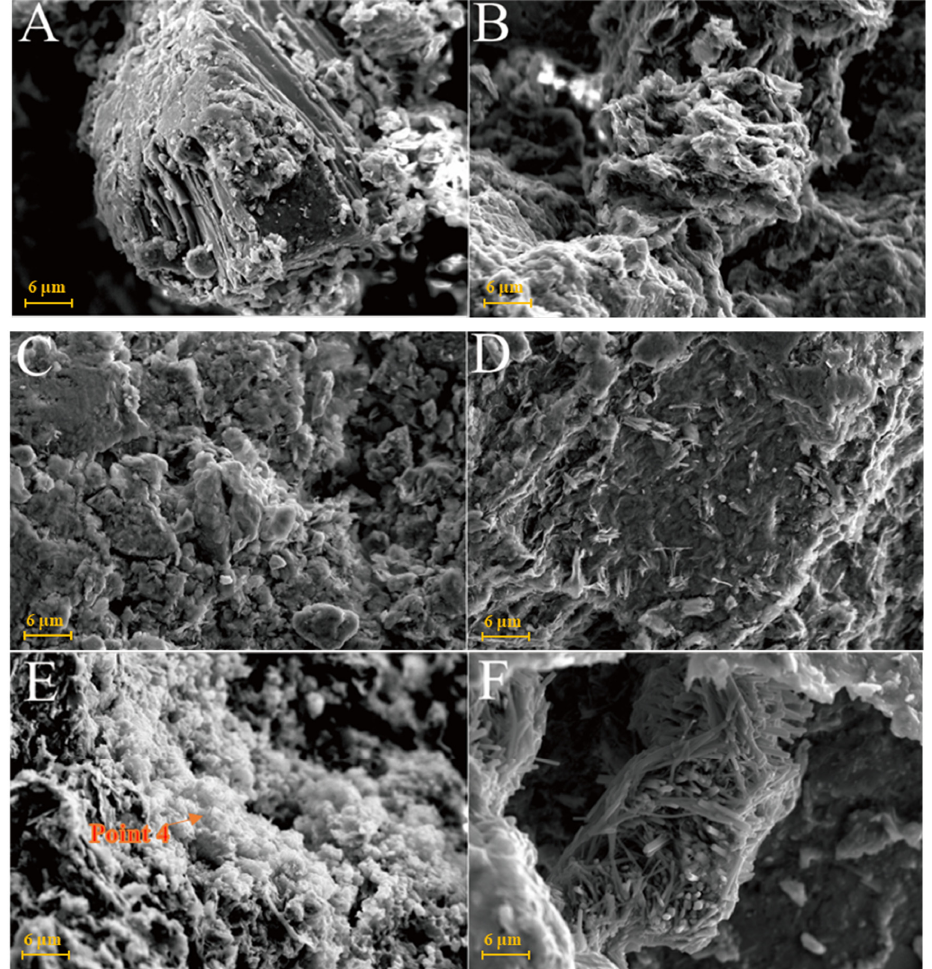
Figure 7. SEM images of montmorillonite samples: ( A )—montmorillonite raw material; ( B )—M0 samples cured for 3 days; ( C )—M0 samples cured for 7 days; ( D )—M0 samples cured for 28 days; ( E )—M0-2 samples cured for 3 days; ( F )—M0-2 samples cured for 7 days.